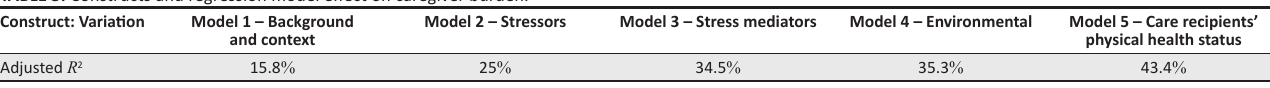
TABLE 3: Constructs and regression model effect on caregiver burden. Construct: